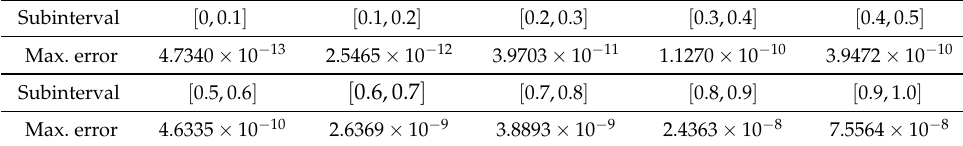
Table 6. Approximation errors for the problem